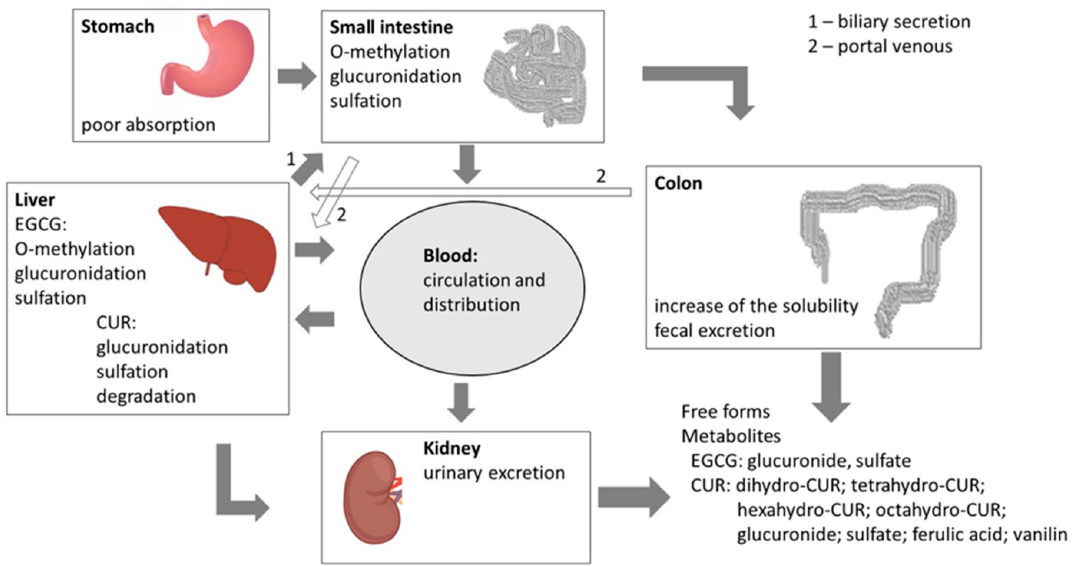
Figure 4. Metabolism of natural polyphenols (CUR and EGCG) (based on Cai et al. [33]).